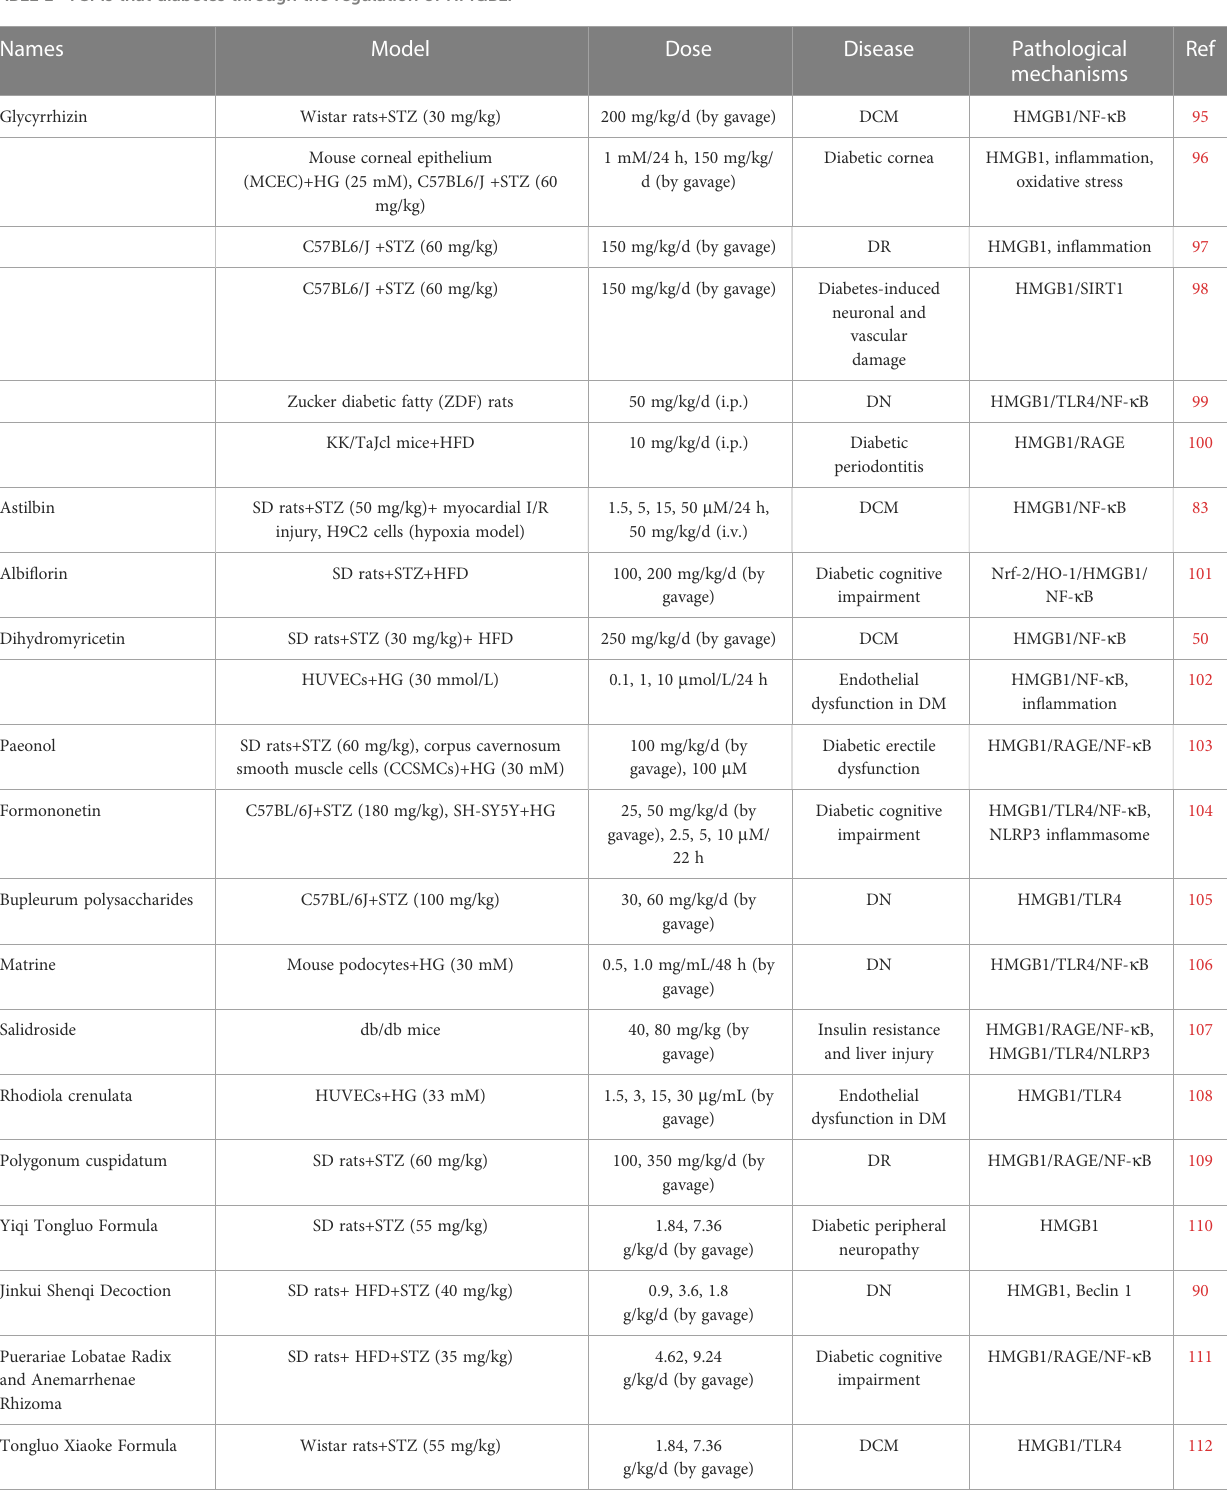
TABLE 1 TCMs that diabetes through the regulation of HMGB1.